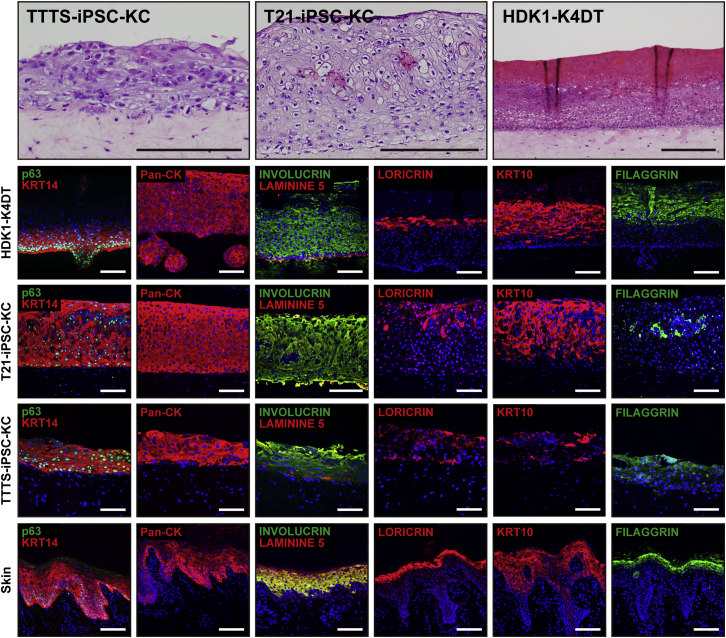
Three-Dimensional Cultured Skin Equivalents Using iPSC-KCs(Upper panels) Histology of 3D skin with T21-iPSC-KCs, TTTS-iPSC-KCs, or HDK1-K4DT. (Lower panels) Immunohistochemical analysis with antibodies to KRT14, p63, Pan-CK, involucrin, laminin 5, loricrin, KRT10, and filaggrin. The multilayered epidermis expressed KRT14, involucrin, laminin 5, Pan-CK, loricrin, KRT10, and filaggrin in artificial skin, indicating that iPSC-KCs terminally differentiate in these skin equivalents. The expression patterns of these markers in intact skin are shown for reference. Scale bars, 100 μm. See also Figure S5.